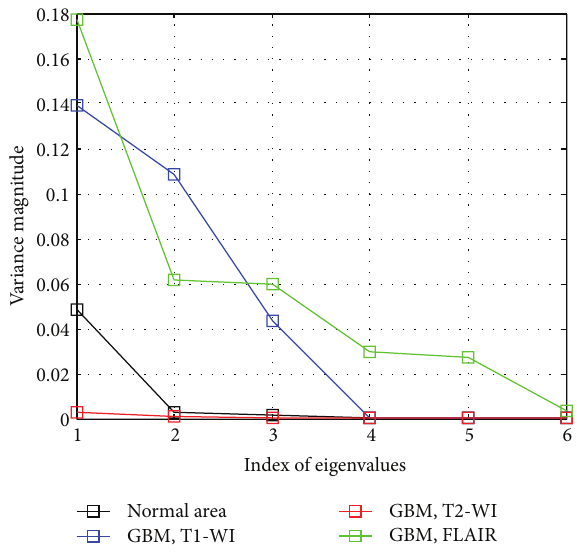
Figure 3: Principal components based on higher variance of GBM and normal areas: (black curve) variance magnitude of 17 normal areas from T1-WI, T2-WI, and FLAIR, (blue curve) variance mag- nitude of 17 GBMs chosen from T1-WI, (red curve) variance mag- nitude of 17 GBMs chosen from T2-WI, and (green curve) variance magnitude of 17 chosen GBMs chosen from FLAIR mode of